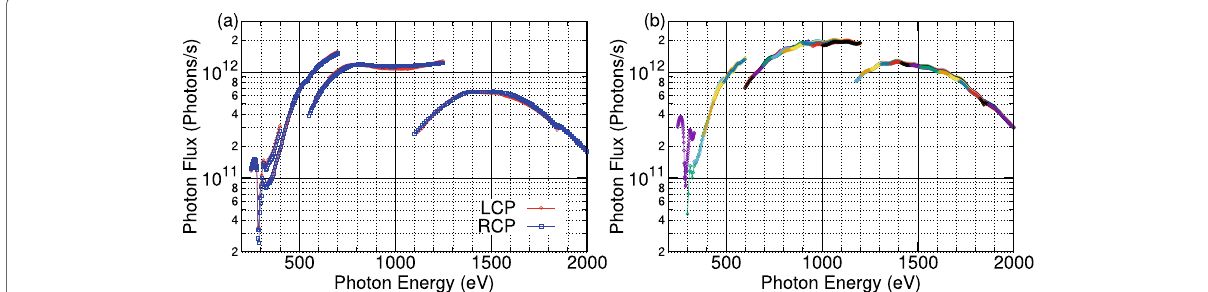
Fig. 16 Photon flux of BL07LSU in CP and LH modes. a Photon flux in CP mode. The red and blue circles correspond to the photon flux of left and right CP (LCP and RCP) modes, respectively. b Photon flux in LH mode. Different colors indicate different n